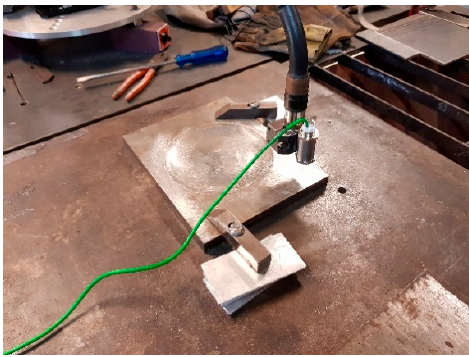
Sensors 2019 , 19 , x FOR PEER REVIEW Figure 17. Scanning process of a metallic block. Figure 17. Scanning process of a metallic block.